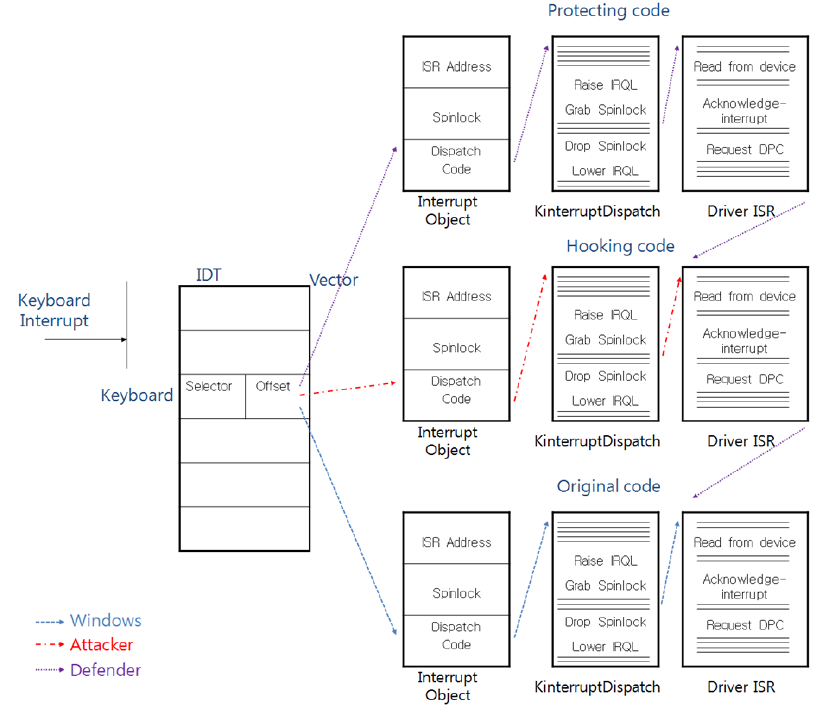
Figure 6. The countermeasure that protects against the IDT-hooking attack.